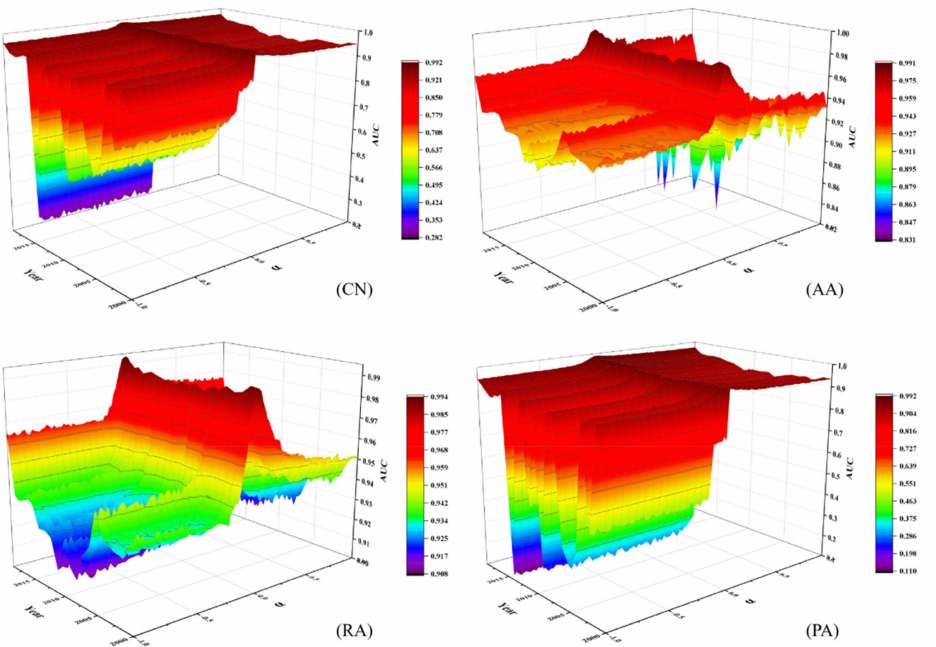
Figure 7. AUC scores of α with year for four different